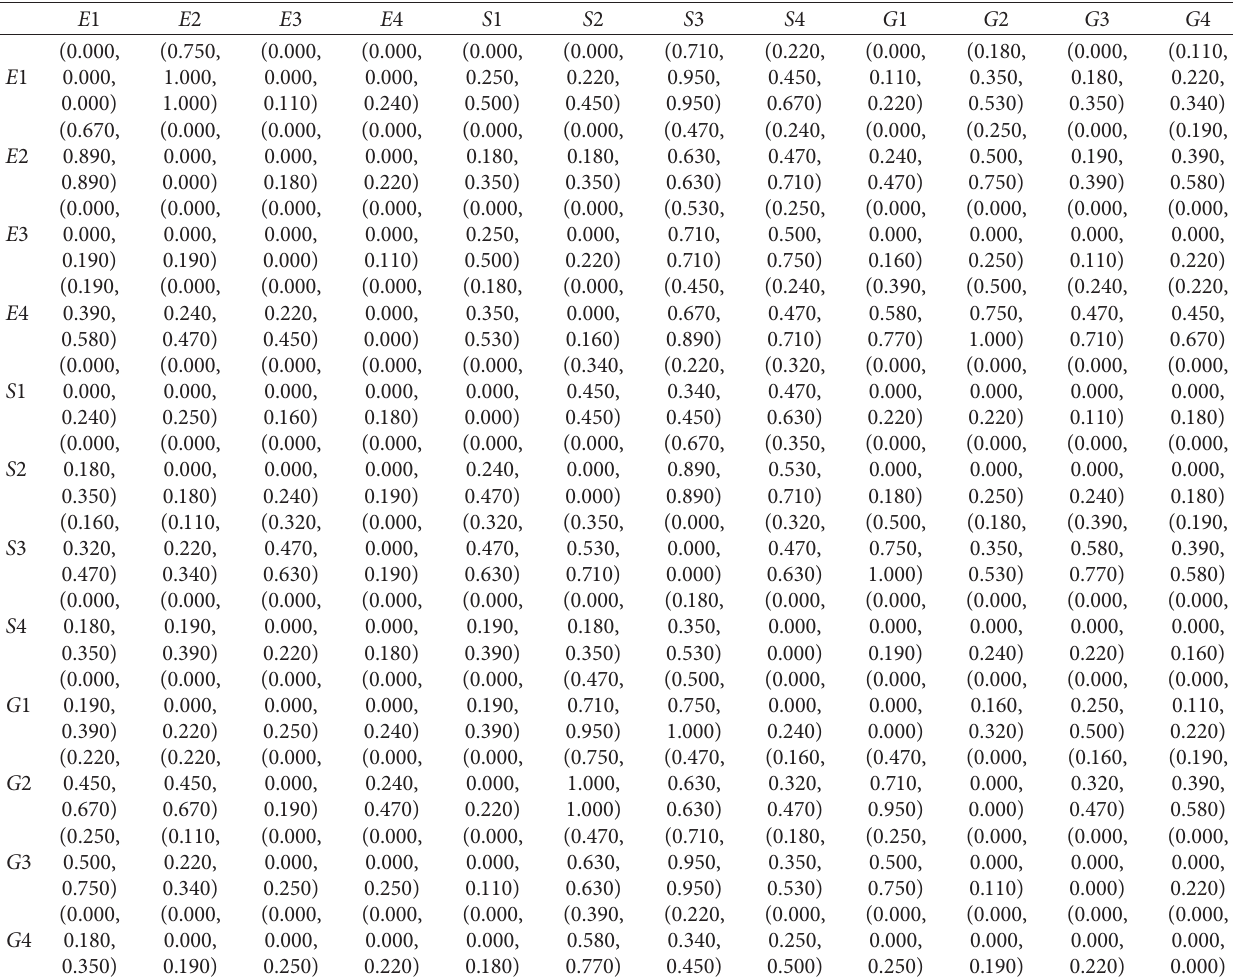
Table 9: Comparison matrix of corresponding numbers to linguistic variable of sustainability criteria in Z-number condition. E